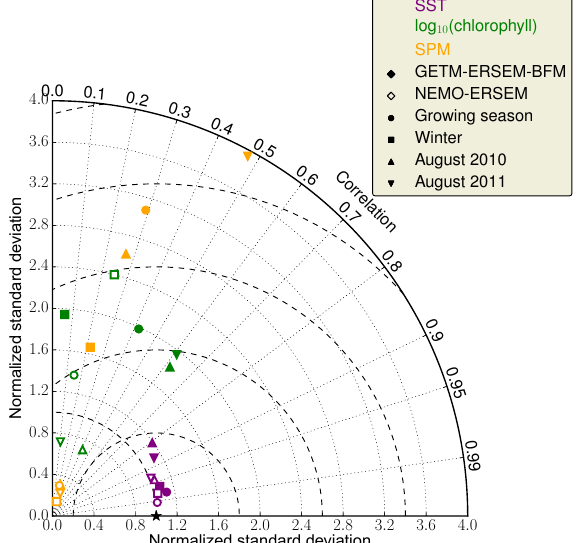
Figure 4. Taylor plot of SST (purple), log 10 (chlorophyll) (green), and SPM (orange) for the growing season (circles), winter (squares), August 2010 (upwards triangles), and August 2011 (downwards triangles). Filled symbols are GETM-ERSEM-BFM, unfilled symbols are NEMO-ERSEM. Validation has been per- formed in observation space, validating the models against OSTIA for SST, and OC5 ocean colour data for log 10 (chlorophyll) and SPM. A perfect model would plot at 1.0 on the x axis, marked with a black star.